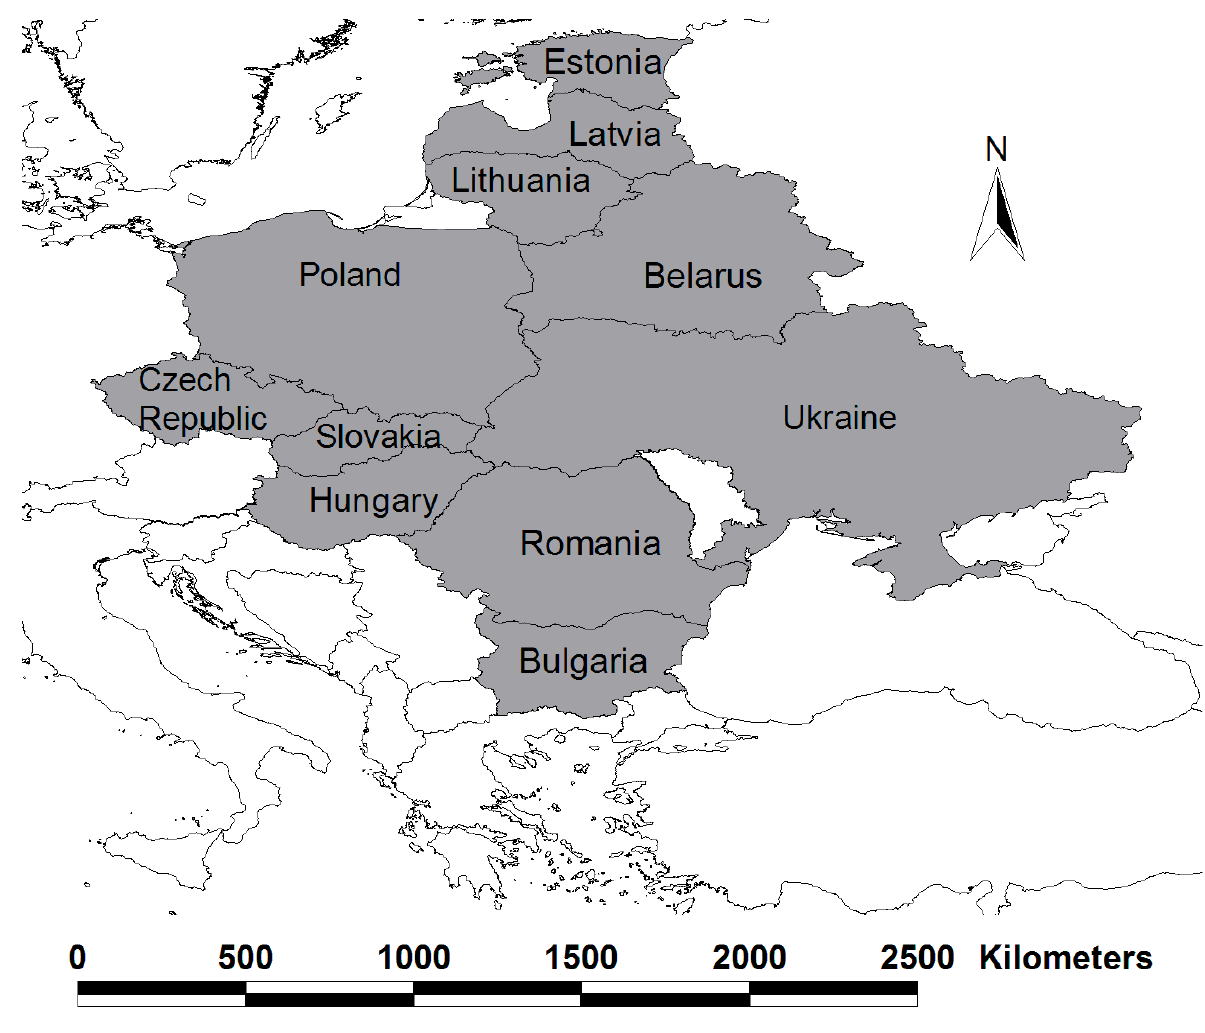
Figure 1. Countries